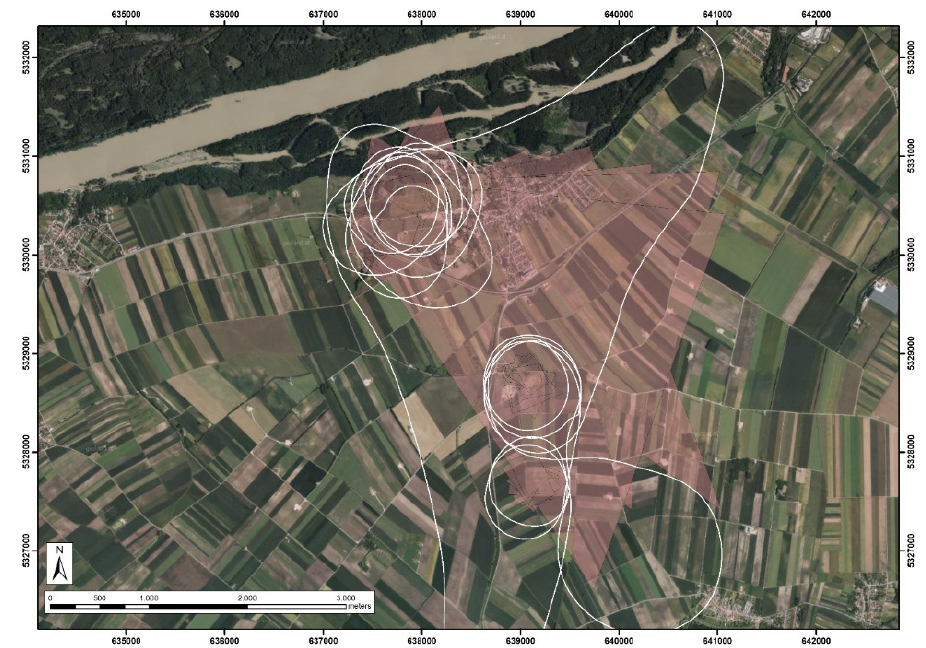
Figure 9. Area of Carnuntum, Lower Austria. White line: recorded flightpath of the aerial archaeological reconnaissance flight from 11 August 2015. Red quadrangles: calculated footprints from all photographs, which were taken during the flight over the area of Carnuntum. Background data source: basemap.at [17].